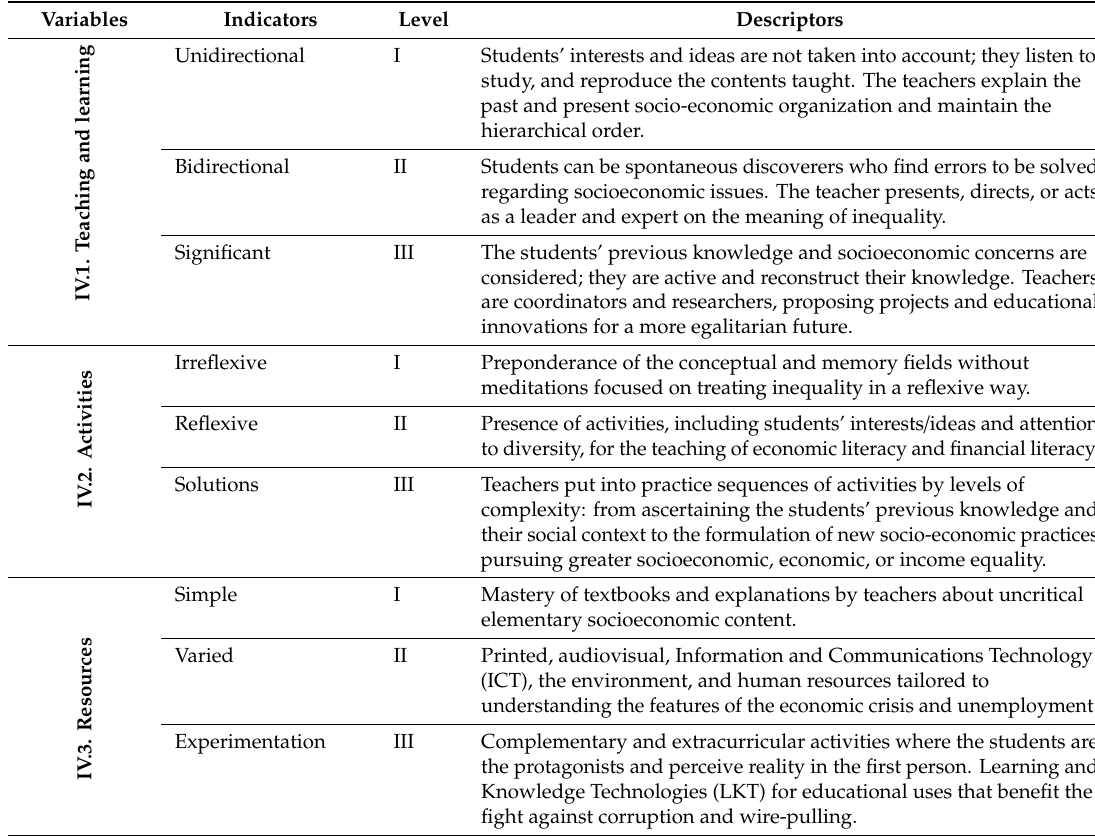
Table 7. System of categories by levels of complexity ( Category: IV. Methodology ). Variables